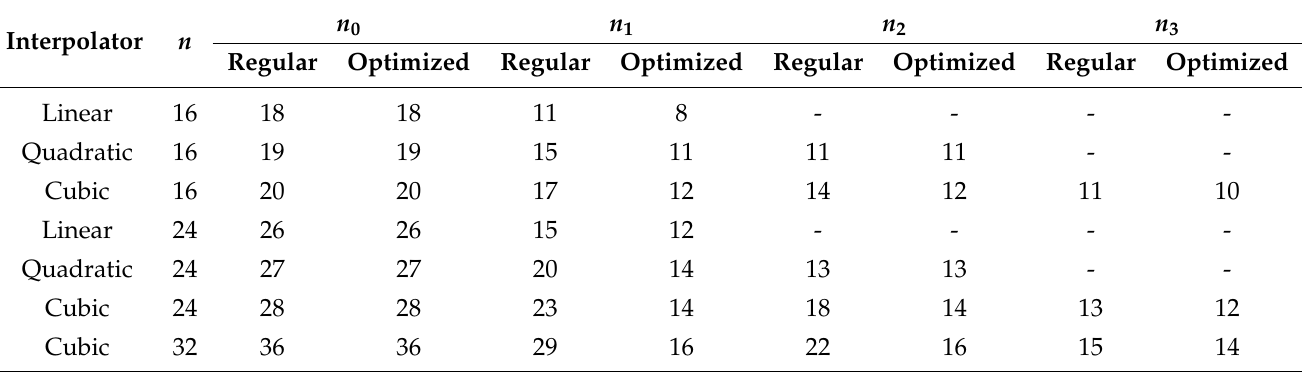
Table 2. Coefficient sizes for regular multipliers vs. optimized truncated multipliers, squarers and cubers, f ( x ) = 1/ x